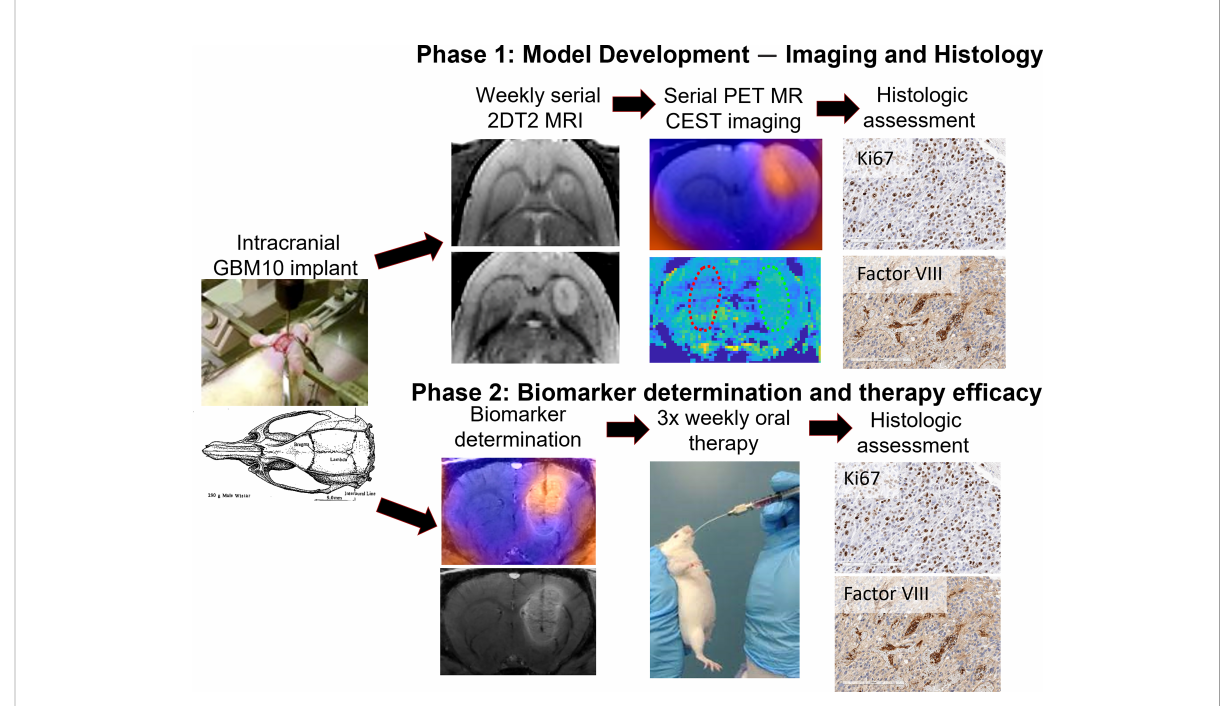
FIGURE 1 Summary of the study design. In the fi rst phase, fi ve rats were intracranially implanted with GBM10 cells and serially imaged initially with a T2 MRI sequence for monitoring lesion growth. Once lesion growth was con fi rmed, the rats underwent serial 18 F-FET PET/CEST MRI on days 42 and 49 post-implantation. Once near-death endpoint criteria were reached, the brains were analyzed immunohistochemically for cellular proliferation (Ki67) and neovascularity (von Willebrand factor VIII). In the second phase, 15 rats were intracranially implanted with GBM10 cells, and on day 49, they underwent imaging for correlation analysis between 18 F-FET PET and CEST MRI. Following imaging biomarker determination, the rats were then selected for similar tumor size across three groups, and oral therapy was administered as follows: vehicle, TMZ alone, or TMZ + idasanutlin. The rats received oral treatment three times weekly until near-death endpoint criteria were reached and were sacri fi ced for histological assessment of therapy